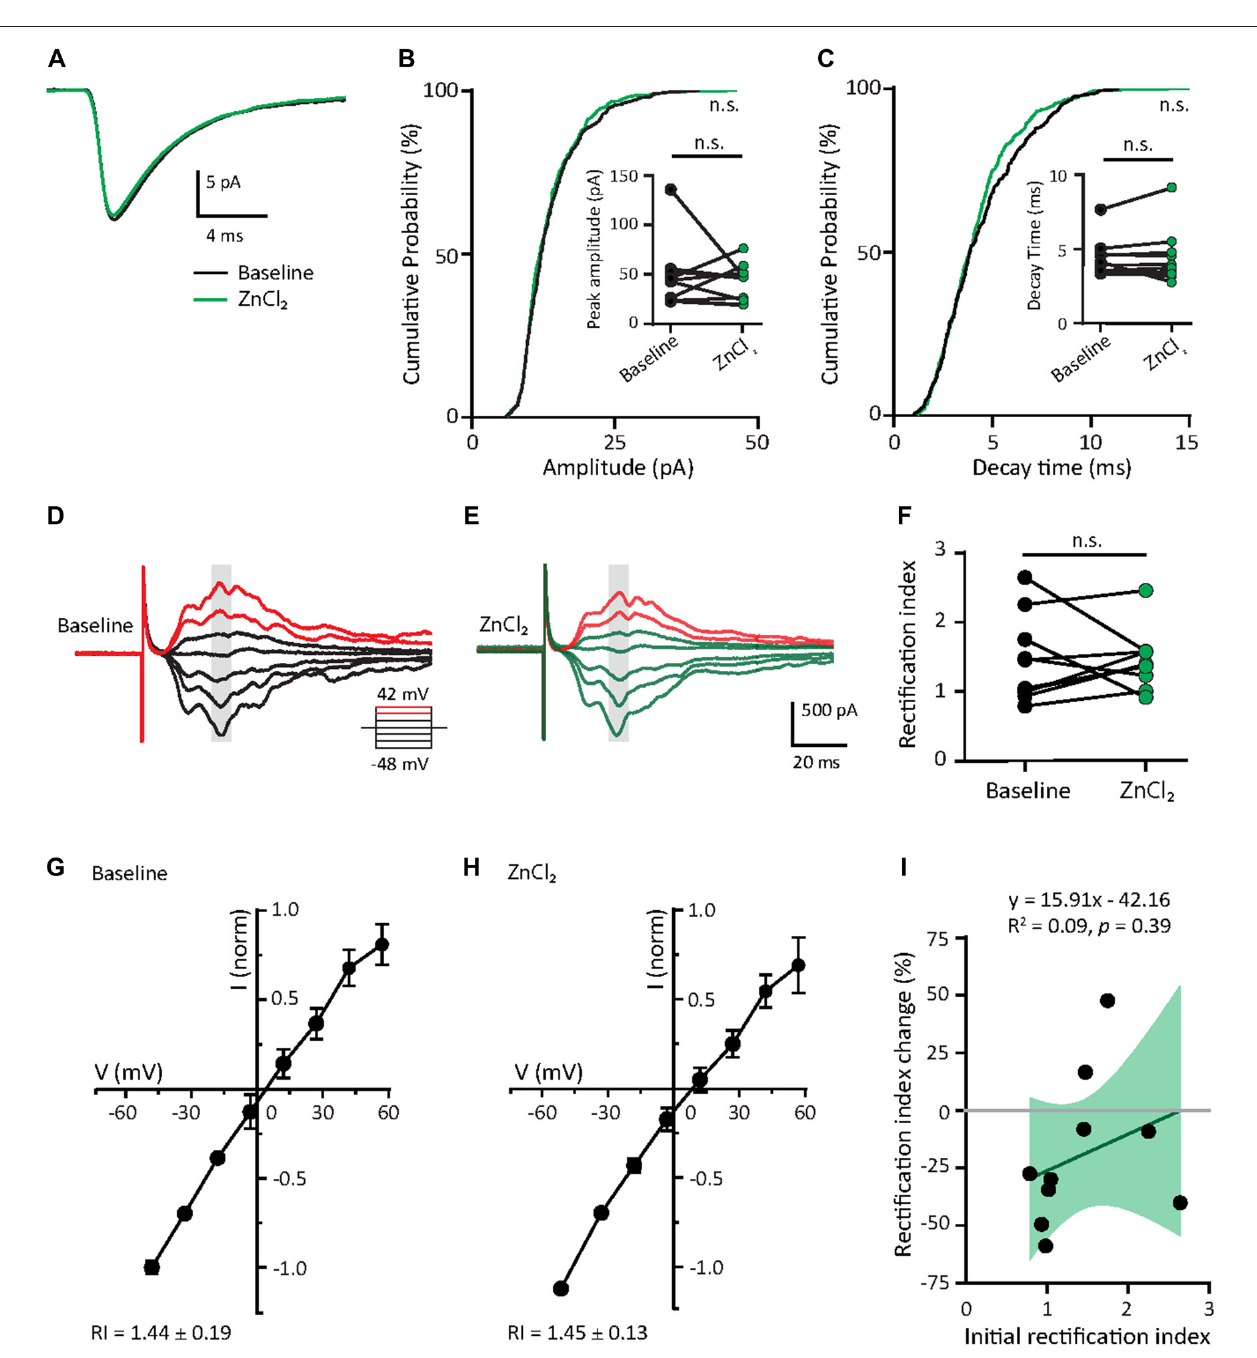
FIGURE 6 | Zinc treatment does not affect miniature or evoked AMPAR EPSCs in mature neurons. (A) Ensemble-averaged mEPSCs from the baseline and zinc conditions recorded in mature neurons (baseline: black, ZnCl 2 : green, N = 10 cells). (B,C) Cumulative probability histograms of amplitude (B) or decay time (C) of isolated events from baseline and ZnCl 2 conditions (K.S. test, N = 400 events from 10 cells from four culture preps per condition, n.s. p ≥ 0.05). Insets display per-cell-basis pairwise comparison of amplitude (B) and decay time ( C ; Wilcoxon test, N = 10 cells, n.s. p ≥ 0.05). (D,E) AMPAR-mediated EPSCs (averaged from three trials) evoked at various holding potentials [diagram (middle)] from a mature hippocampal neuron (DIV 18) during baseline (D) and after 10 min of 10 µ M ZnCl 2 application (E) . Red traces correspond to the current response at the two most positive holding potentials. Gray shaded bars mark the regions used for calculating peak current amplitude in (G,H) . (F) Summary graph showing effect of ZnCl 2 application on RI of mature neurons (Wilcoxon test, N = 10 cells from three culture preps, which applies to all subsequent panels unless otherwise specified; n.s. p ≥ 0.05). (G,H) Normalized current-voltage relationship (mean ± SEM) of the pooled data recorded from the same neurons at baseline (G) and ZnCl 2 treatment (H) . (I) Relationship between the initial RI (during baseline) and the magnitude of RI change with ZnCl 2 application (Pearson correlation, n.s. p ≥ 0.05). Green shaded area indicates the 95% confidence interval.